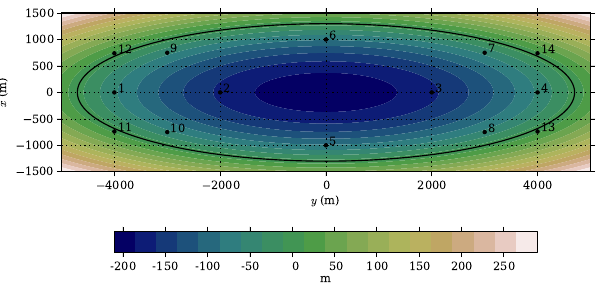
Fig. 7. Benchmark n. 1: synthetic tide gauge records located at dif- ferent distances from the shore, close to the inundation area, show the progressive advance of the wave up to the slope. Notice that positive (negative) coordinates mark offshore (onshore) positions. Among the eight records shown here, only the ones in the range ( − 100m, 100m) are in the wet-dry zone: when the record is con- stant, the node is dry.